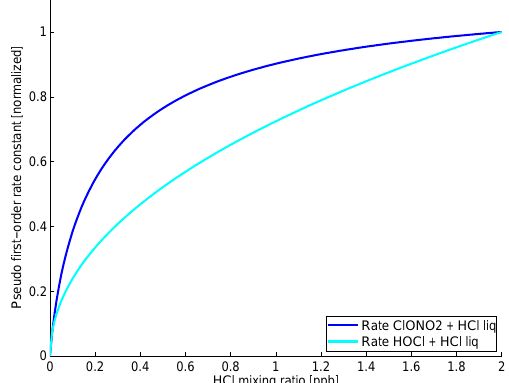
Figure 6. Normalized pseudo first-order rate coefficients as a function of HCl mixing ratio for the heterogeneous reactions ClONO 2 + HCl (blue) and HOCl + HCl (cyan) on liquid STS sur- faces. Reaction rates were calculated for T = 190K, p = 50hPa, 10ppb HNO 3 , 0.15ppb H 2 SO 4 , 4ppm H 2 O and 1ppb ClONO 2